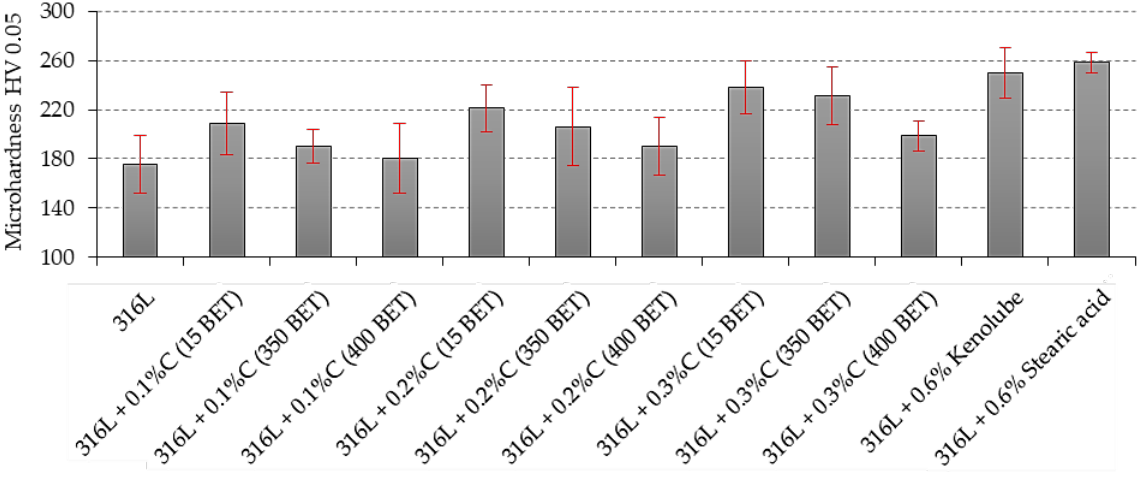
Figure 12. Rockwell hardness B scale of sinter, measured from the side of the upper and lower punch, depending on the percentage composition of the tested mixtures.